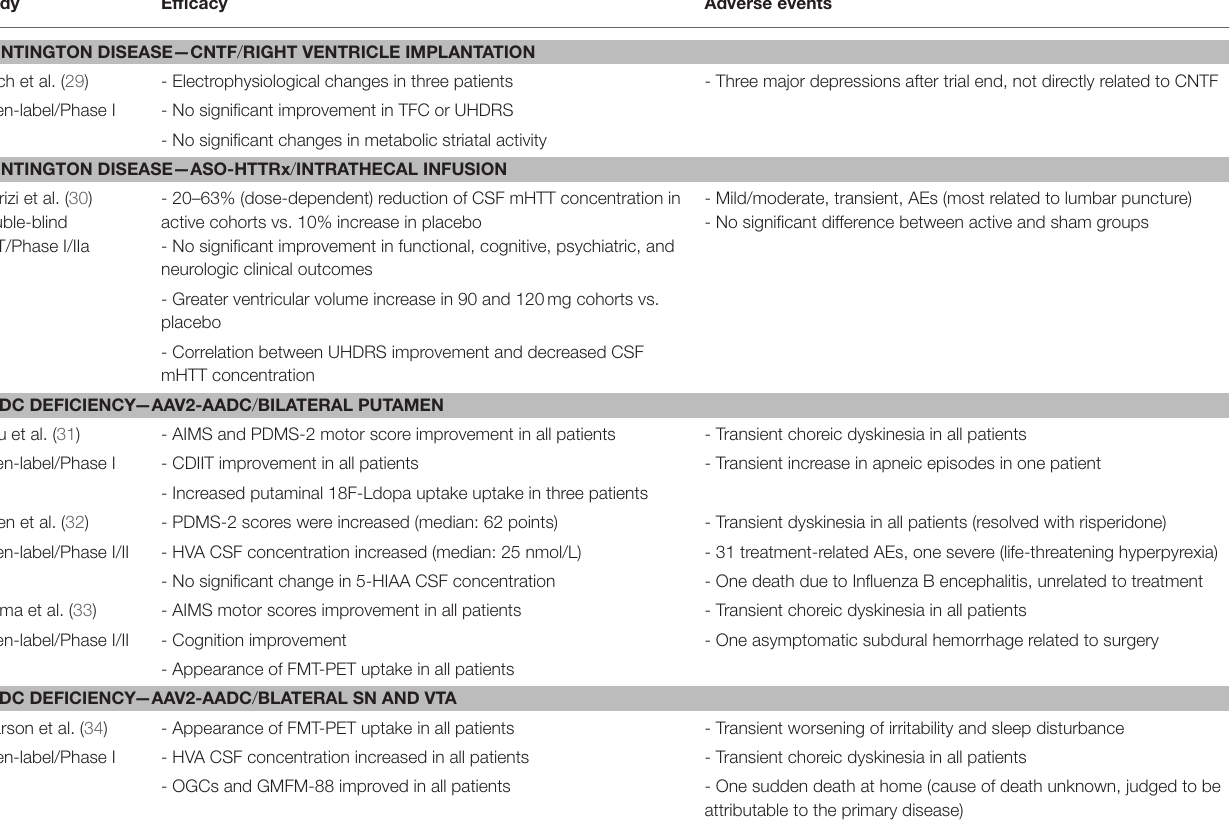
TABLE 6 | Reviewed articles—efficacy and safety—other diseases. Study Adverse